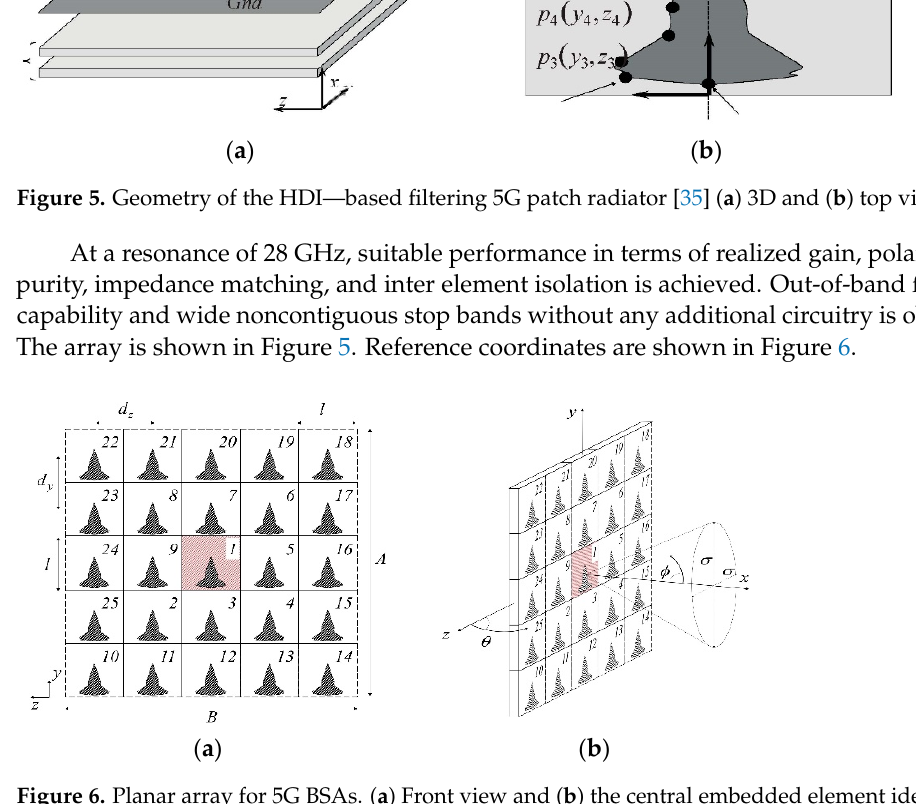
Figure 6. Planar array for 5G BSAs. ( a ) Front view and ( b ) the central embedded element identifying the referenced coordinate